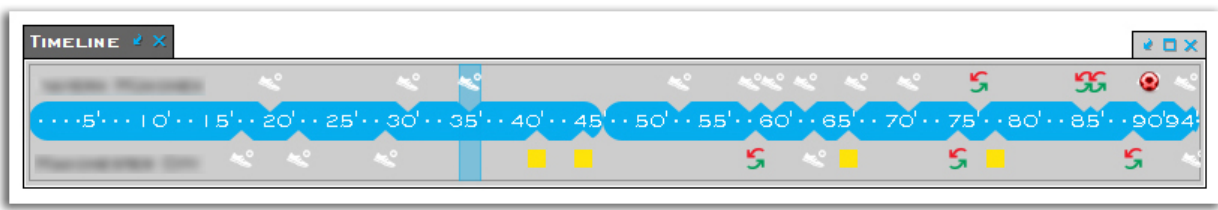
Figure 4. Timeline allowing quick navigation to every moment of the game. User-selected events, like fouls, goals or exchanges, are